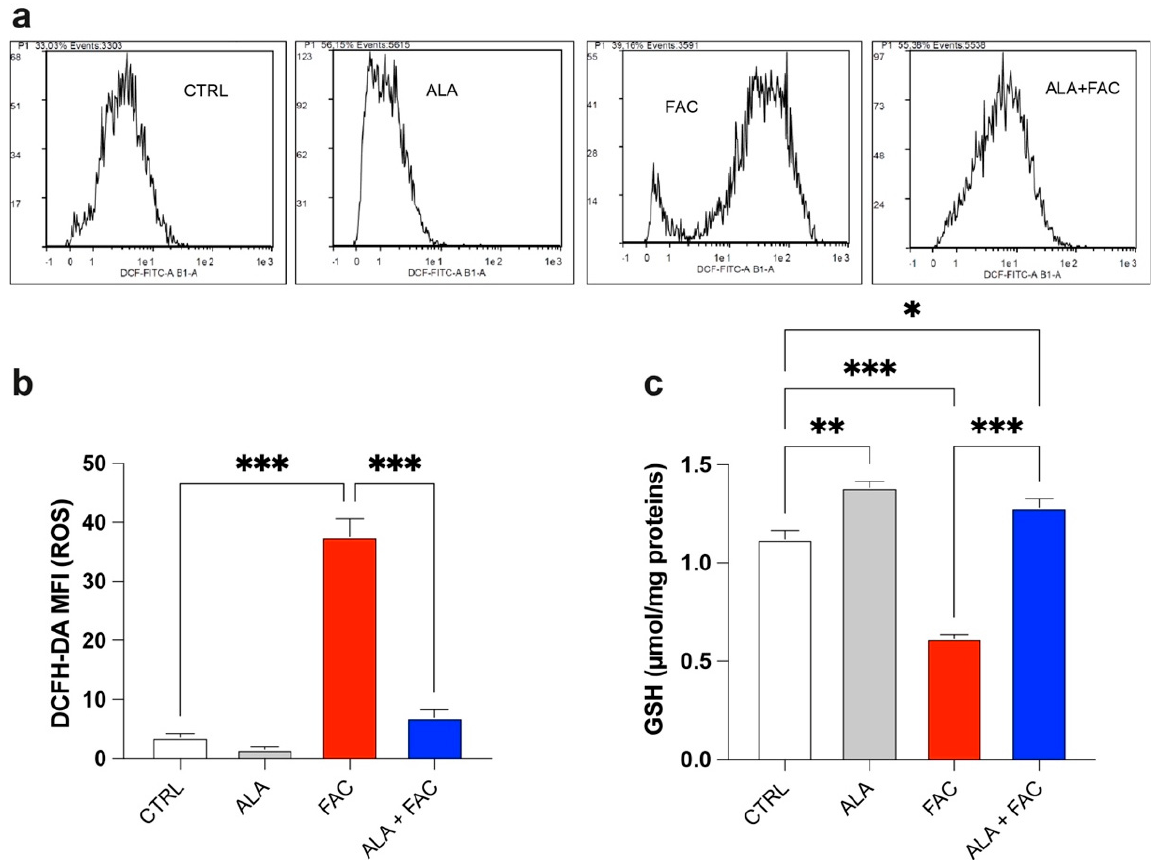
Figure 3. Iron overload affects mitochondrial functionality inducing oxidative stress. ( a , b ) Representative plots ( a ) and quantification ( b ) of DCFH-DA fluorescence intensity via cytofluorimetric analysis in control, ALA-, FAC- and ALA + FAC-treated HMC3 cells; ( c ) Quantification of intracellular content of reduced GSH analyzed by spectrophotometric assay in control, ALA-, FAC- and ALA + FAC-treated HMC3 cells. * p -value < 0.05; ** p -value < 0.01; *** p -value < 0.001.